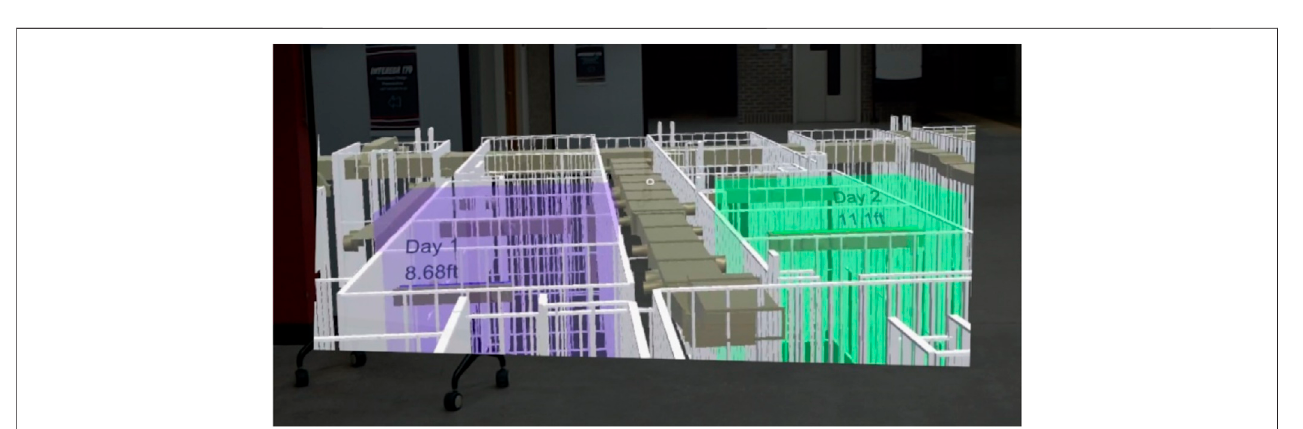
FIGURE 5 | Production